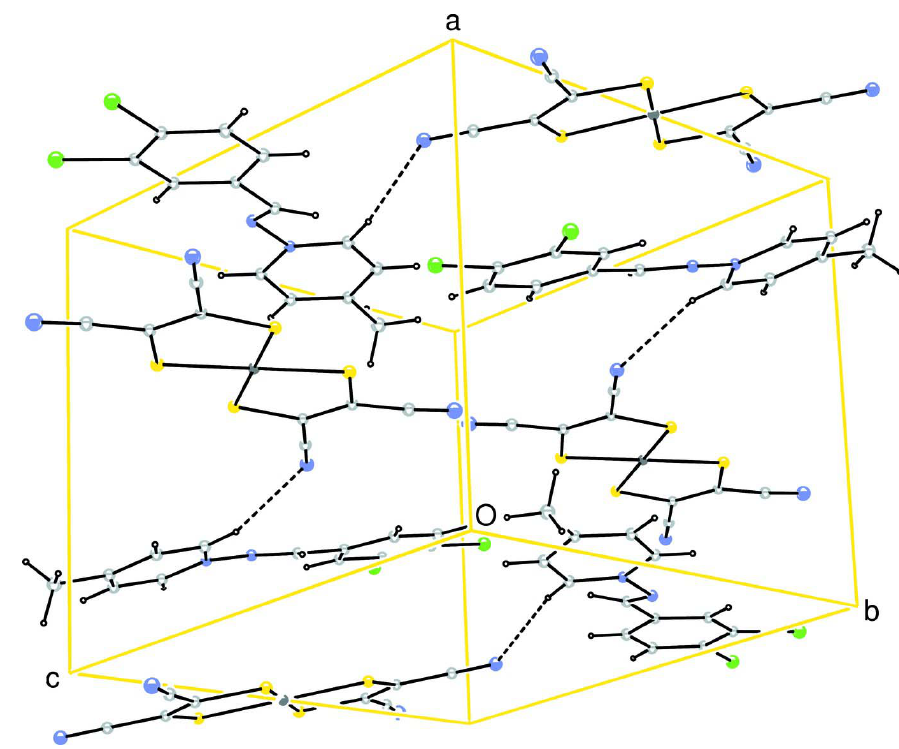
Figure 2 A partial packing diagram of the title compound. Hydrogen bonds are shown as dashed